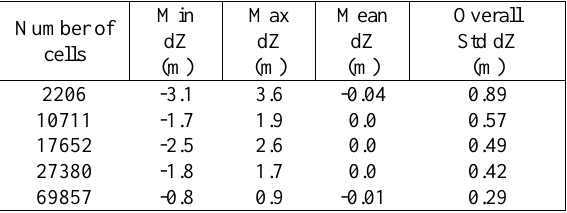
Table 3. Results of the comparisons of Q-tree DTMs vs. full resolution DTMs